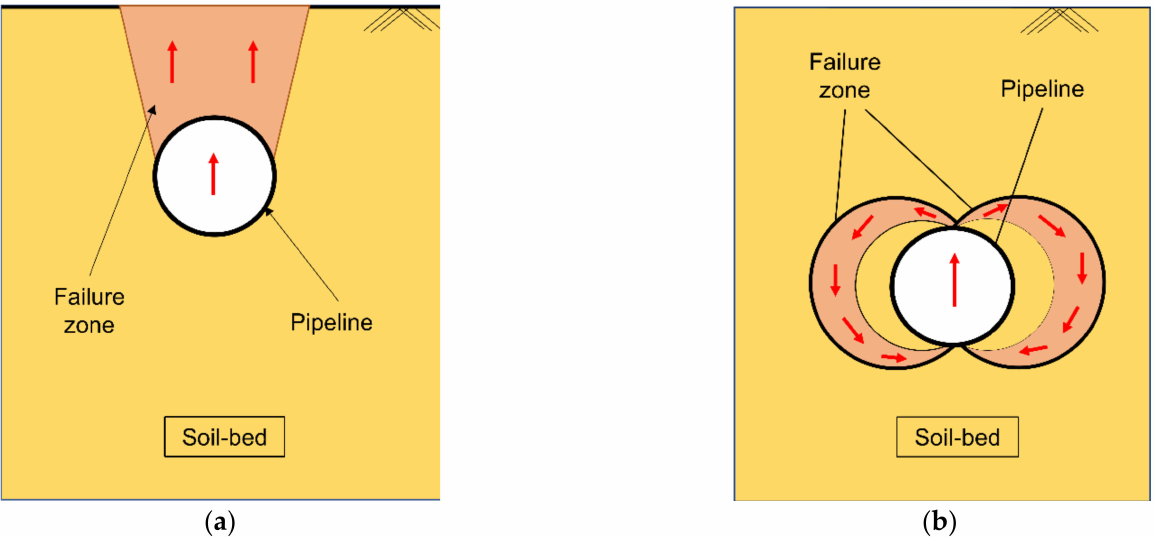
Figure 14. Typical displacement contour for soil failure for ( a ) shallow and ( b ) deeply embedded pipeline during pipe uplifting in NT condition, a conceptual diagram from the FEA generated displacement contour [59].